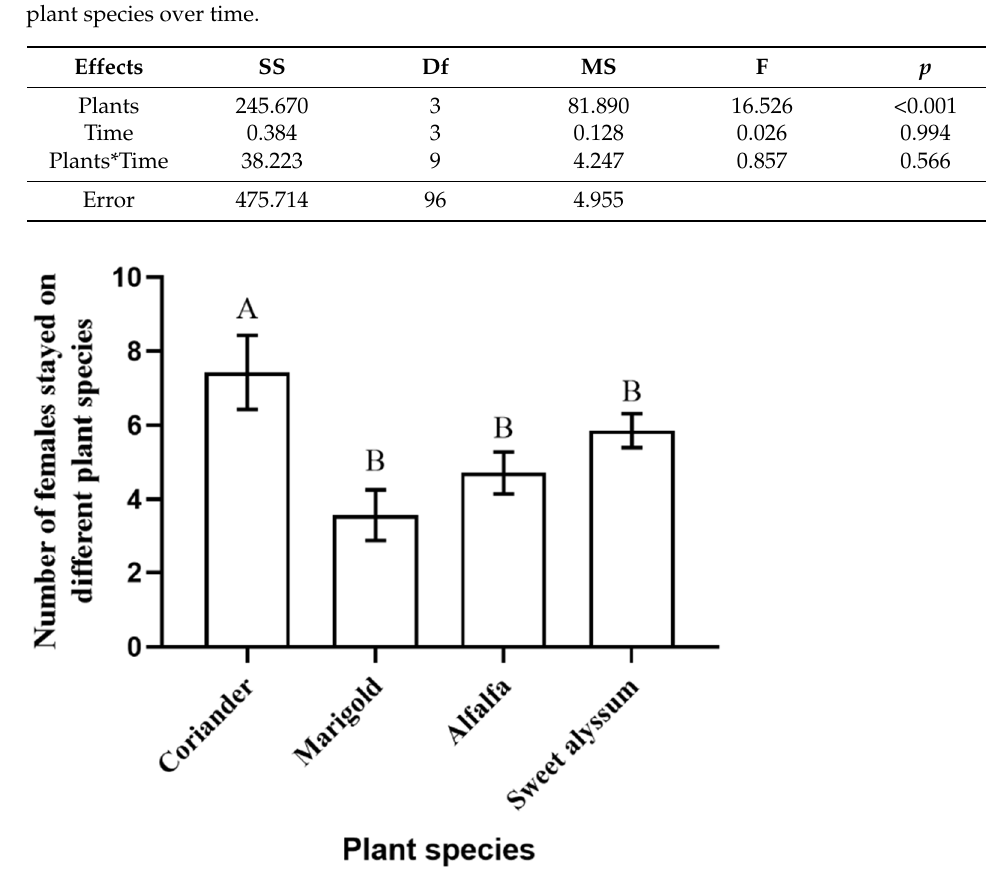
Figure 1. The preference of Orius sauteri females among four plant species after 30 min ( n = 11; α = 0.05; ANOVA). Values are mean ± SE (Standard Error). Means indicated by the same letter are not significantly different according to Least Significant Difference (LSD) test.